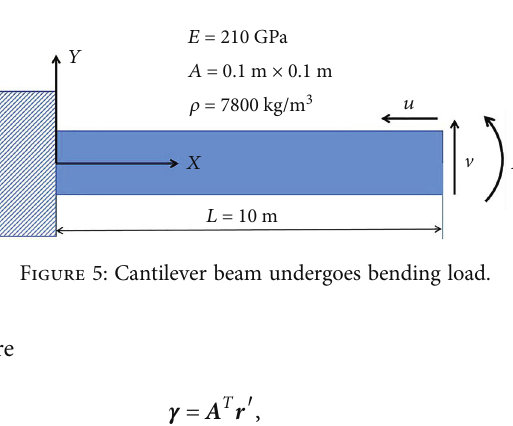
Figure 4: Flexible beam element.